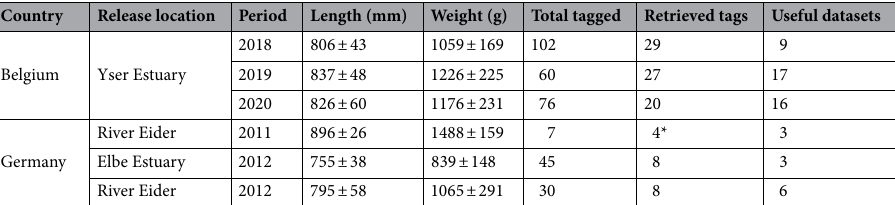
Table 1. The number of tagged eels, retrieved tags and useful datasets with tracks ≥ 100 km per release location and period. The average length ± SD and weight ± SD is indicated. *PSATs attached to the eels in the River Eider in 2011 were not retrieved, but the data was obtained via transmission by the ARGOS satellite system.